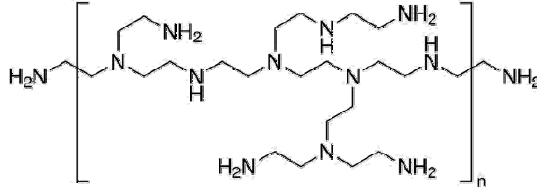
Figure 3. Molecular structure of PEI.